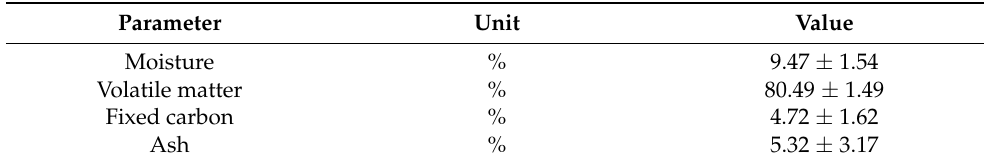
Table 1. Saccharum spontaneum L. feedstock proximate analysis.